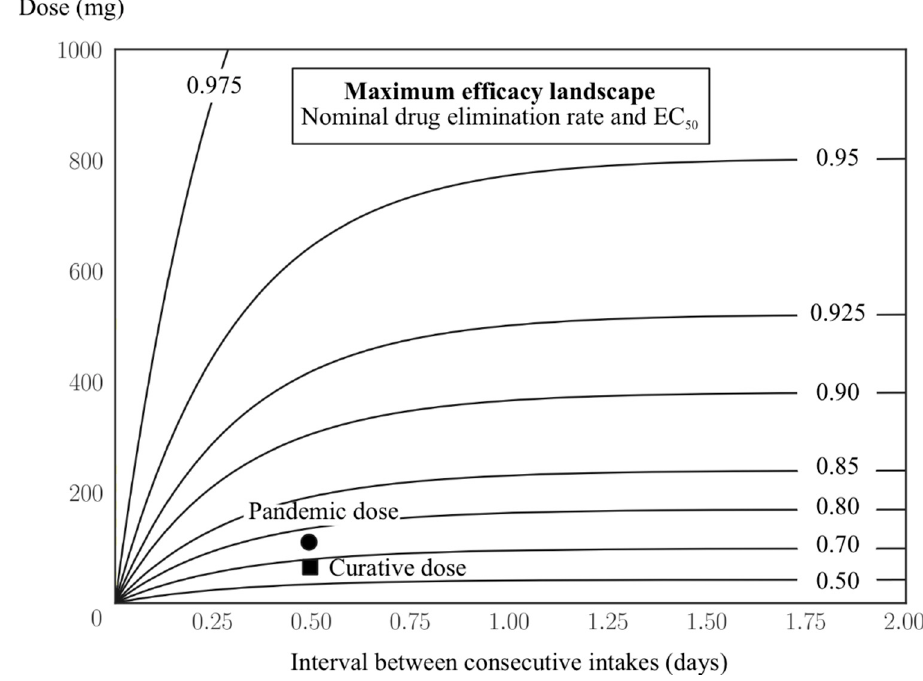
Figure 6. Maximum efficacy landscape of oseltamivir regarding the frequency of intakes and dose per intake. Contour lines mark the level of efficacy that can be theoretically achieved given a treatment combination. Values of the drug efficacy are shown for the two current recommended regimens.